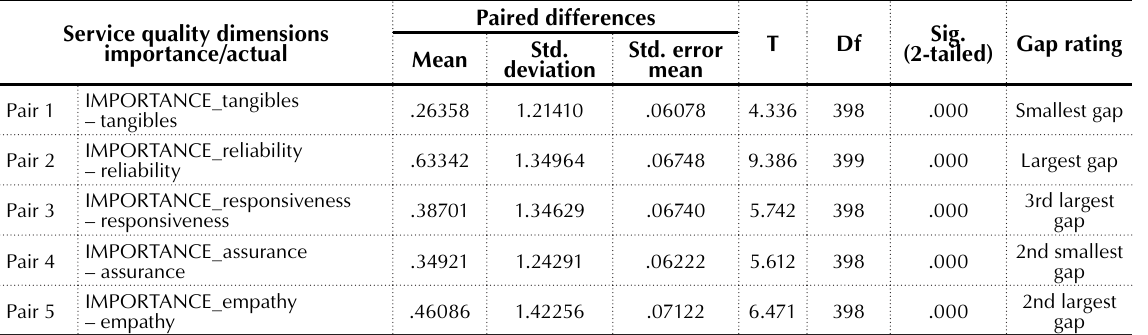
Table 9. Actual and importance rating for each service quality dimension